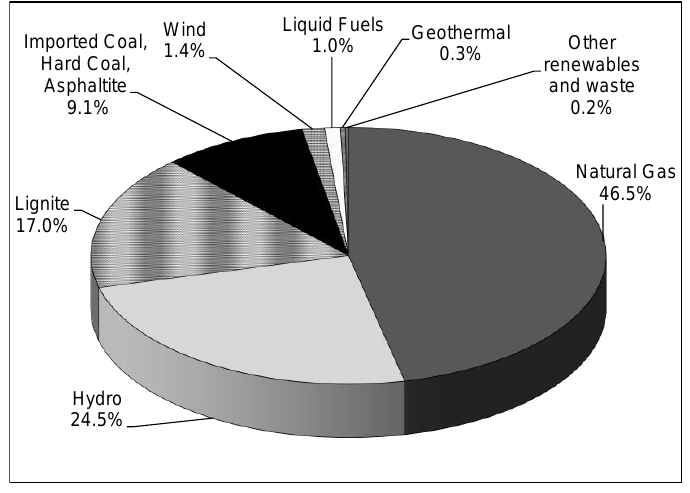
Figure 1. Share of different fuels in electricity generation in Turkey in 2010 [4].